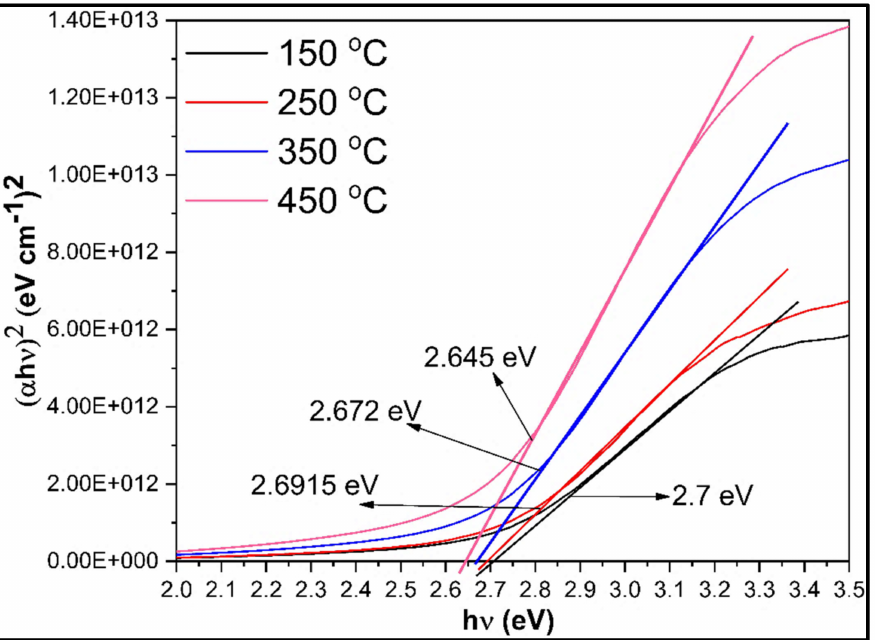
Figure 9. Tauc plot ( α h ν ) 2 versus energy band gap (h ν ) of ZnO nanoparticles synthesized by using a green method and the leaf extract of the thyme plant at different calcination